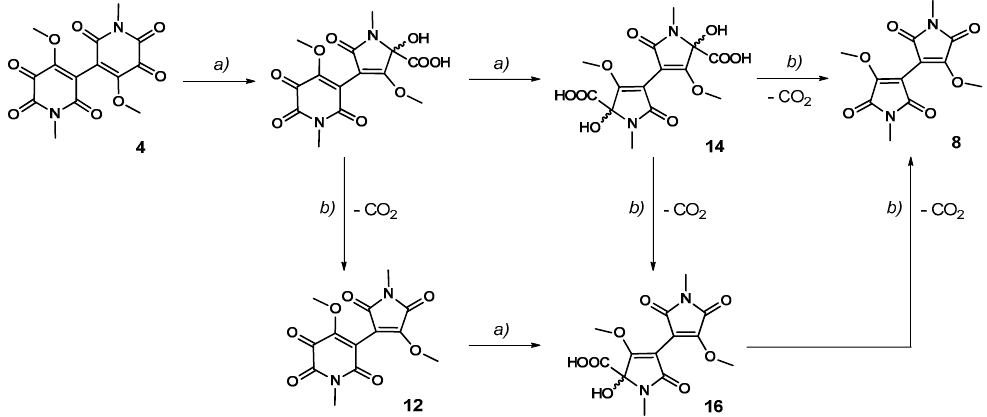
Figure 7. Proposed metabolic pathway of a step-wise conversion of chrysohermidin ( 4 ) into plicatanin B ( 8 ). ( a ) Benzilic acid type rearrangement and ( b ) decarboxylation. The intermediates 14 and 16